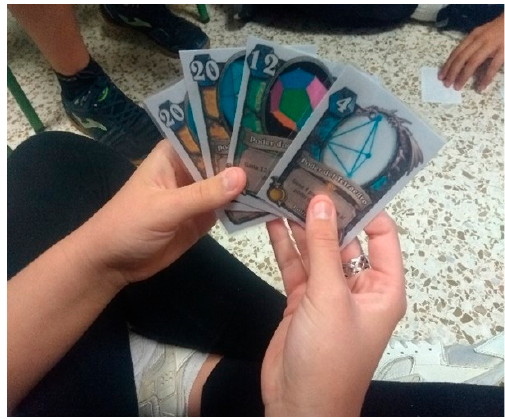
Figure 1. Cards with points, polyhedral, and